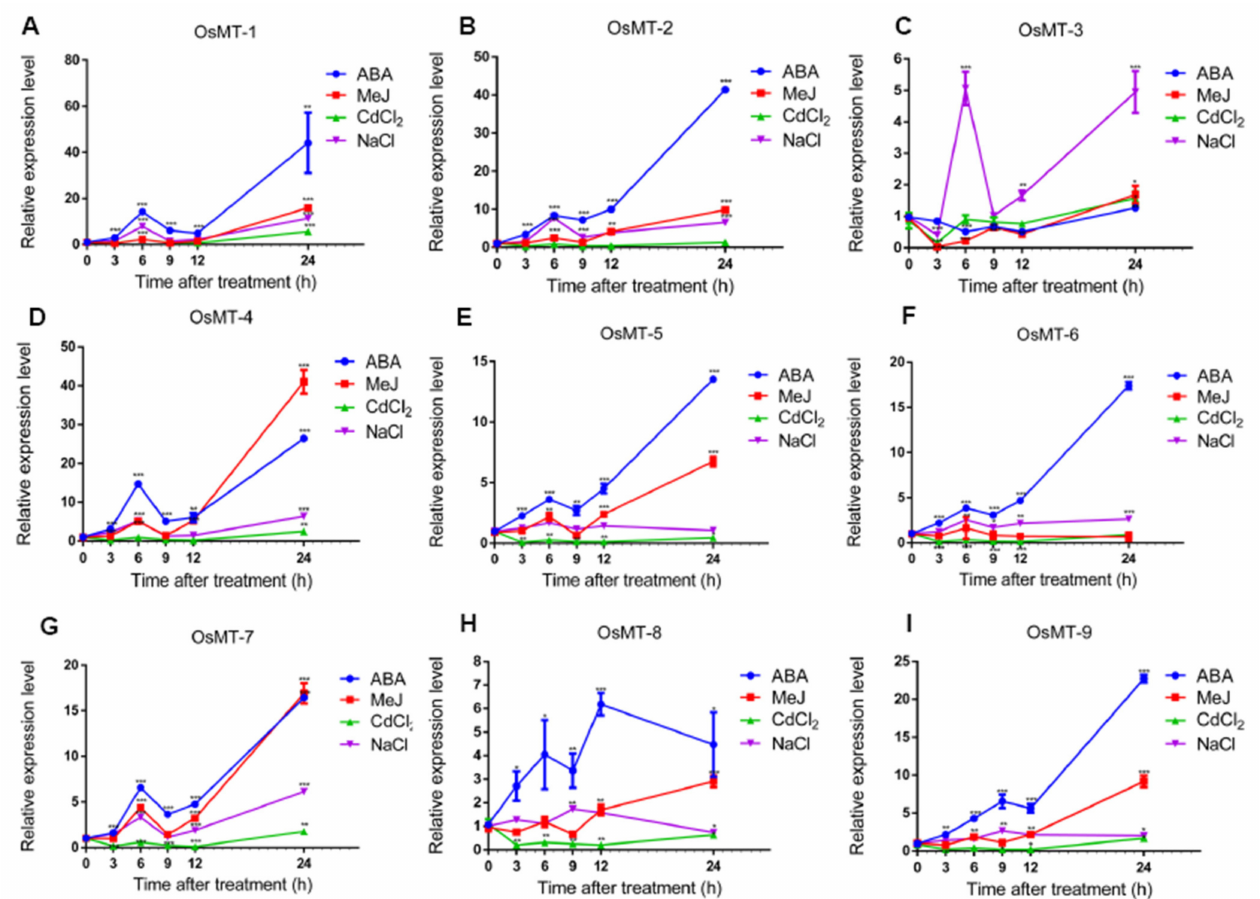
Figure 7. qRT-PCR of relative expression of OsMT genes in shoots at the rice seedling stage under various abiotic stress treatments, including NaCl, CdCl 2 , ABA, and MeJ: ( A – I ) the expression of OsMT genes was calculated at 3, 6, 9, 12, and 24 h of treatments compared with the expression value at 0 h, which was normalized to 1. The error bars show the standard deviations of the three independent qRT-PCR biological replicates. The significance analysis was performed using t -test; *: p < 0.05, **: p < 0.01, ***: p <